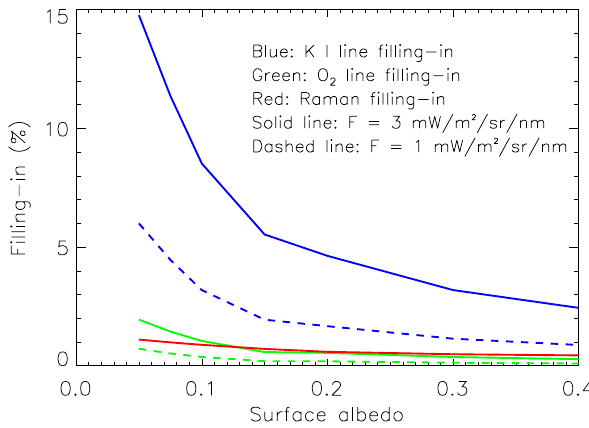
Fig. 3. Simulated GOSAT filling-in of the O 2 weak line at 769.9nm and the K I line as a function of surface albedo. Filling-in of the K I line due to both fluorescence and rotational-Raman scattering is shown.